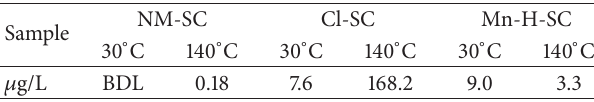
Table 4: TCLP experiment results of three kinds of